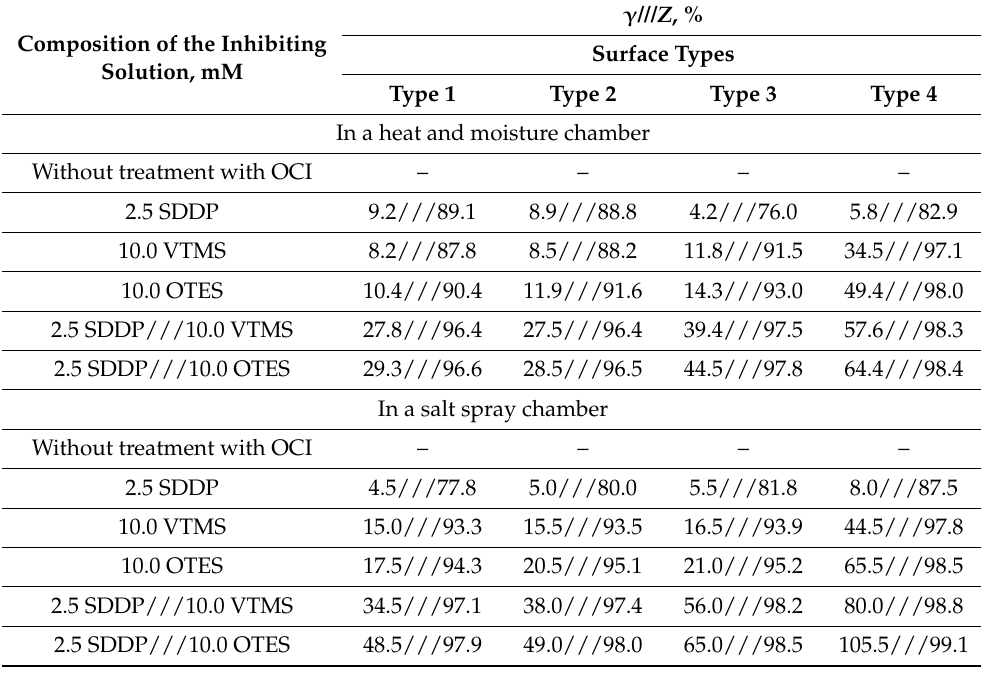
Table 4. γ and Z values calculated based on the results of corrosion tests in aggressive atmospheres of zinc samples with different surface morphology, treated in SDDP and TASs